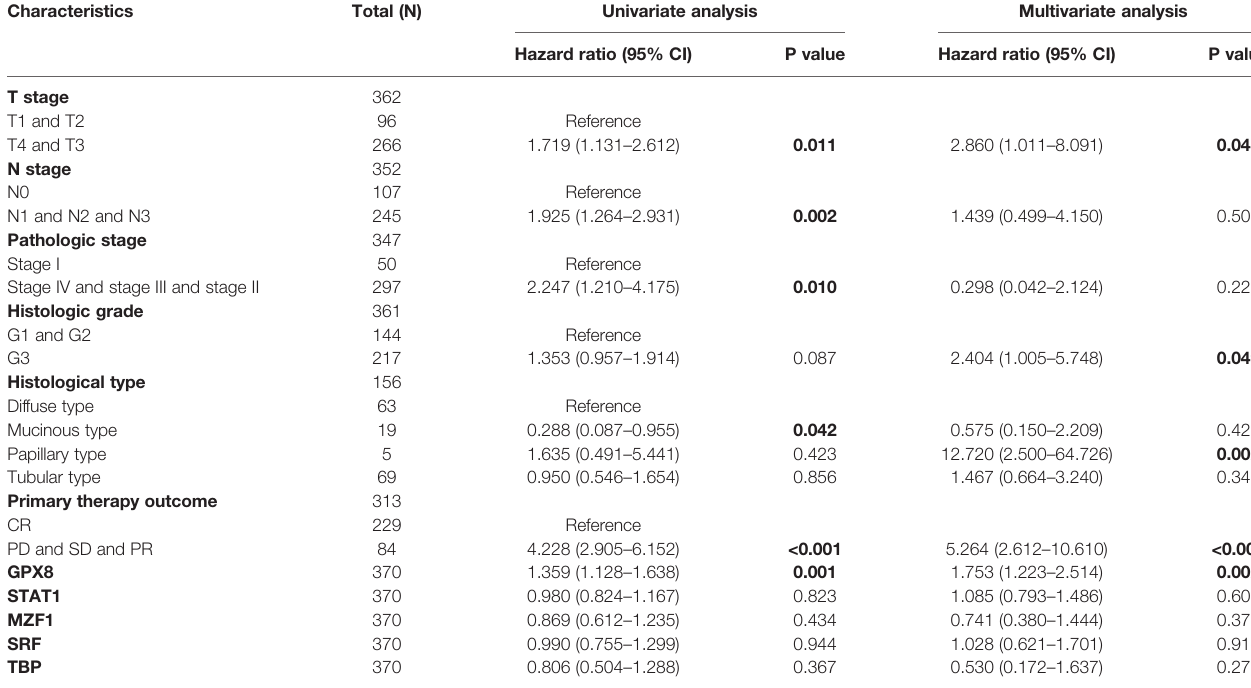
TABLE 1 | Univariate and multivariate COX regression in patients with stomach